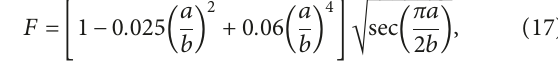
. I Measured K I (MPa · m 0.5